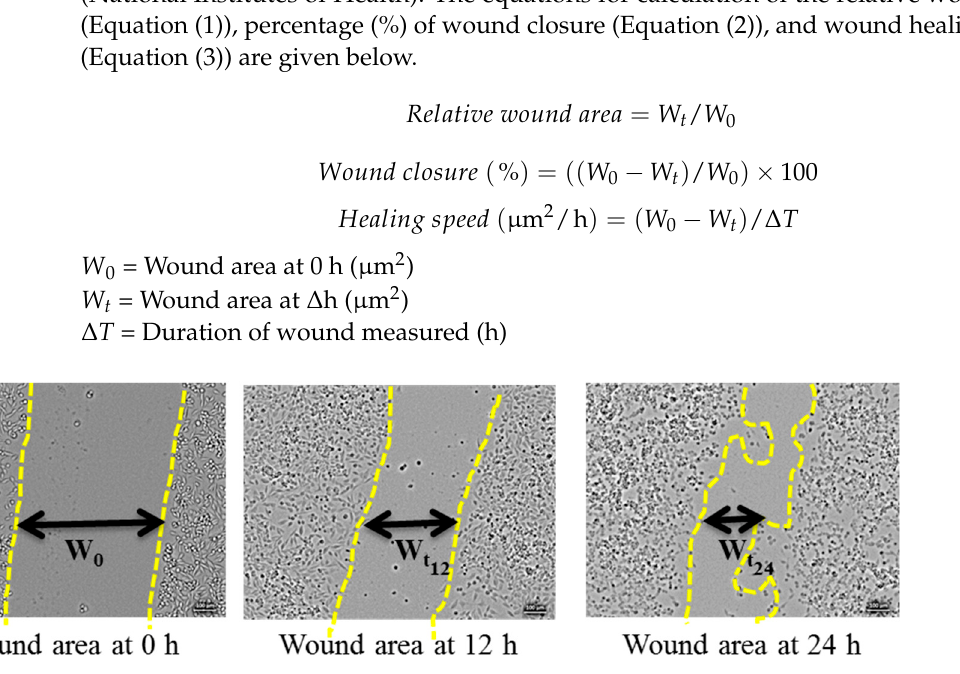
Table 1. The accuracy of different machines learning algorithms in Classification Learner App.